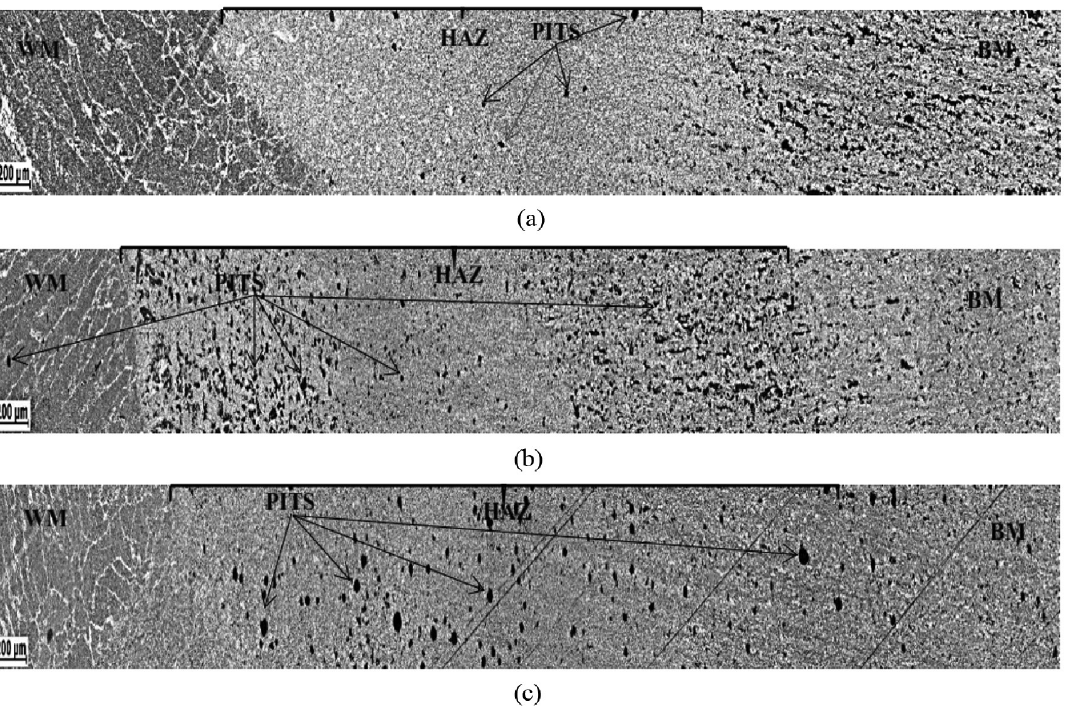
Figure 6. OM images of the surface appearance of the specimens after the removal of corrosion products in different environments. (a) WJ in brine, pH=5.0. b) WJ in solution 1, pH=3.0. c) WJ in solution 2, (Figure 5) and using SEM (Figures 7-8). The structure and composition of the films were determined using EDS and